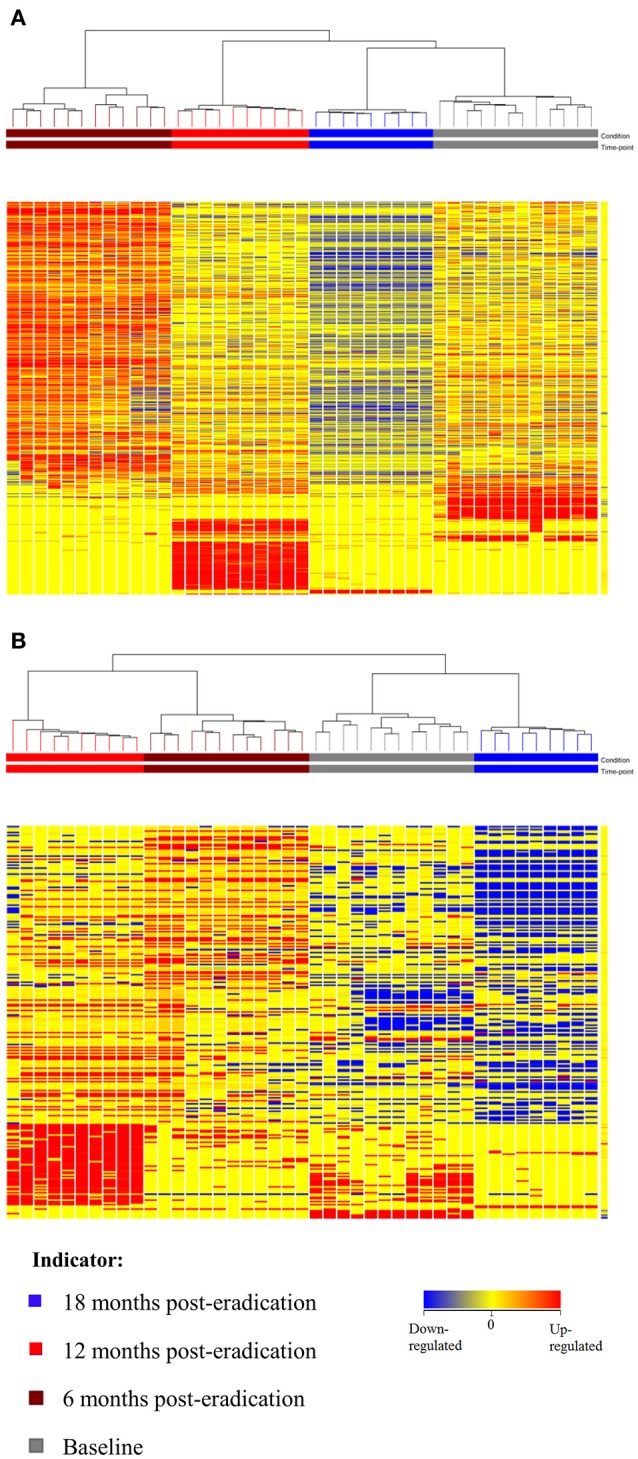
HCA dendrogram of plasma metabolomics for Baseline, 6, 12, and 18 post-H. pylori eradication, acquired under both (A) positive and (B) negative ionization modes.